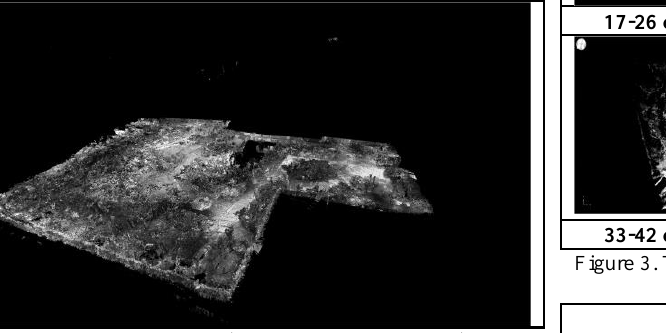
Figure 2. 3D point cloud data (delete more than 1m data)